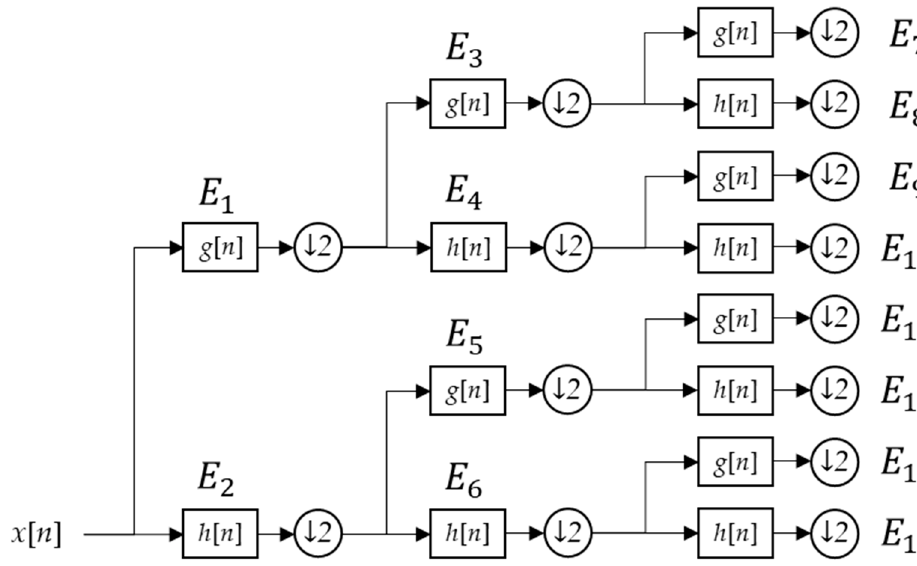
Figure 3. Description of tree decomposition of WPD.